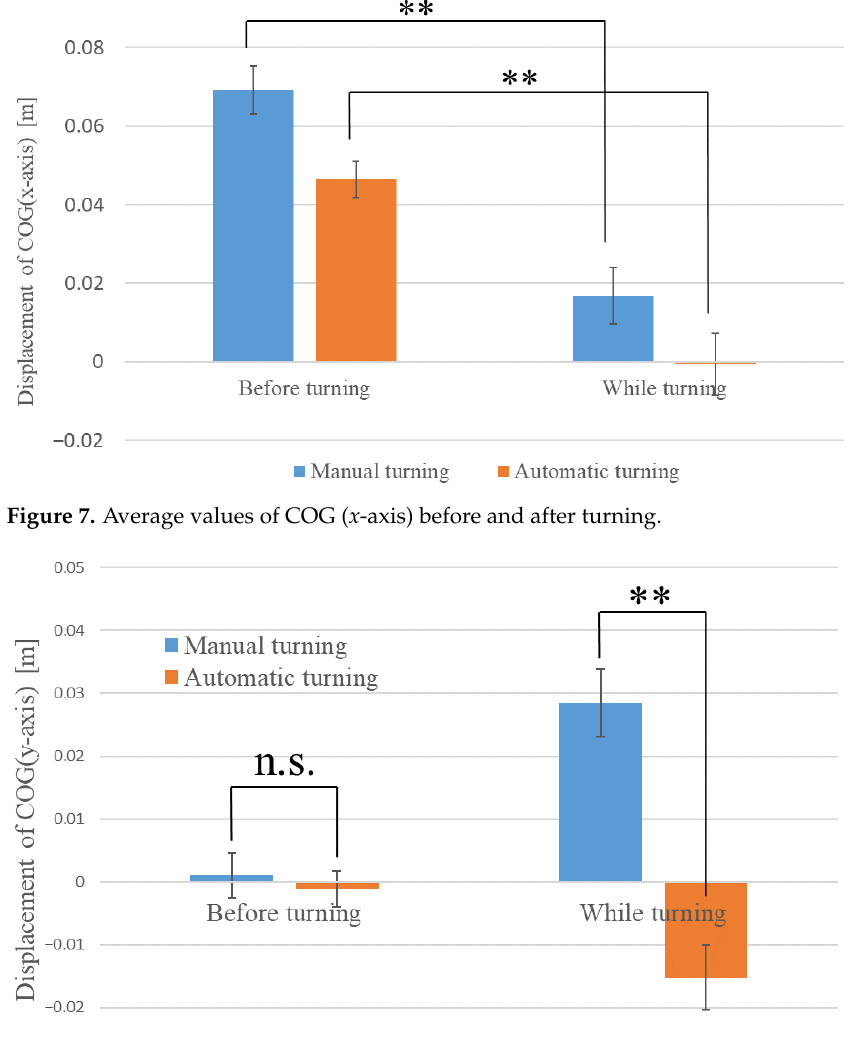
Figure 7. Average values of COG ( x -axis) before and after turning.